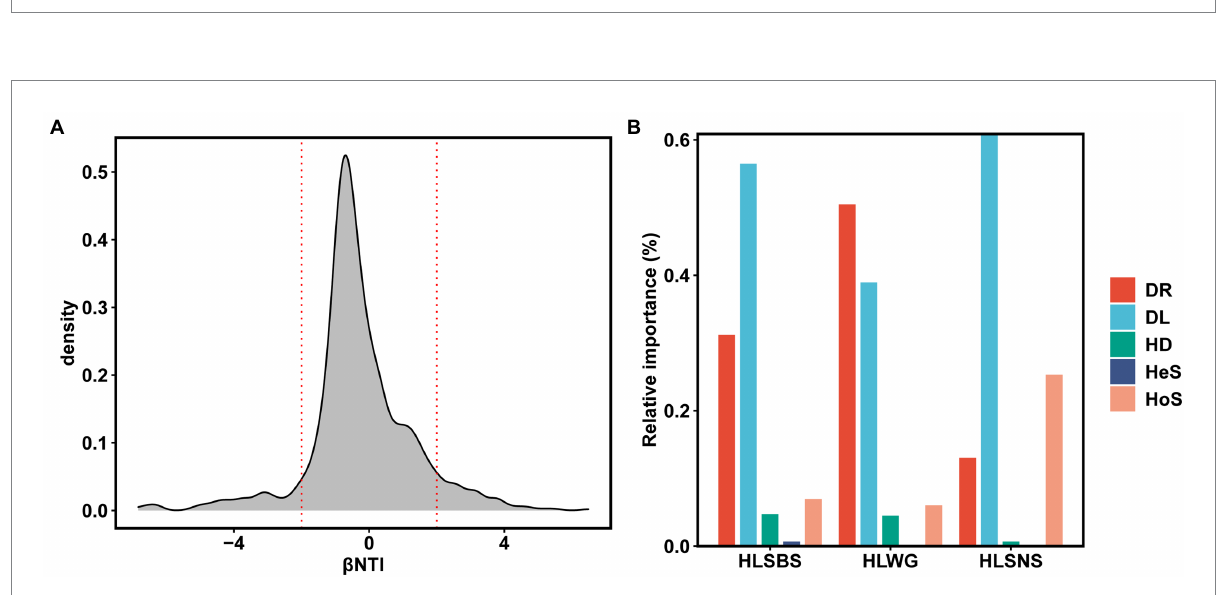
FIGURE 6 Ecological processes underlying community assembly of ectomycorrhizal (EM) fungi. (A) Beta nearest taxon index ( β NTI); (B) relative importance of ecological processes in determining EM fungal communities in each site. HoS, homogeneous selection; HeS, heterogeneous selection; HD, homogenizing dispersal; DL, dispersal limitation; and DR: drift and